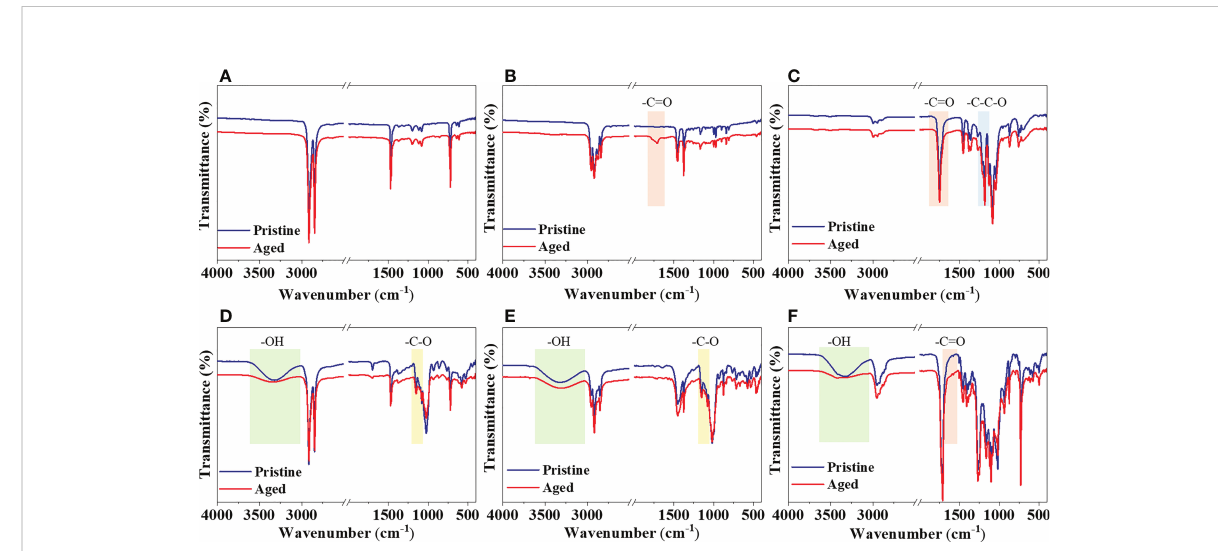
FIGURE 3 ATR-FTIRspectraofthepristineand agedMPs treatedby2monthsof UVirradiationinnatural seawater. (A) PE, (B) PP, (C) PLA, (D) PE/TPS, (E) PP/TPS, and (F) PLA/PBAT/TPS.PE, polyethylene;PP,polypropylene;PLA, polylacticacid;PE/TPS, polyethylene/thermoplasticstarchblends;PP/TPS, polypropylene/ thermoplasticstarchblends;andPLA/PBAT/TPS,polylacticacid/poly (butyleneadipate- co